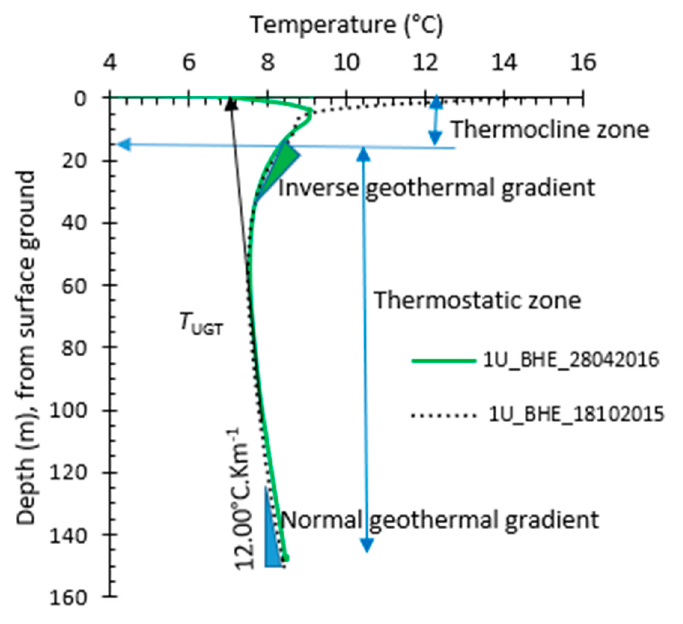
Figure 7. Observed undisturbed ground temperatures at the INRS experimental site.